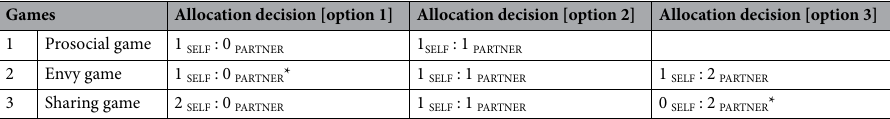
Table 1. Experimental games. Three games: in each game a player had to make a decision of how to allocate candies between himself/herself and/or a virtual partner. Each game was played twice: once toward an anonymous friend, and once toward an anonymous stranger of the same age. * decisions that deviate from the original